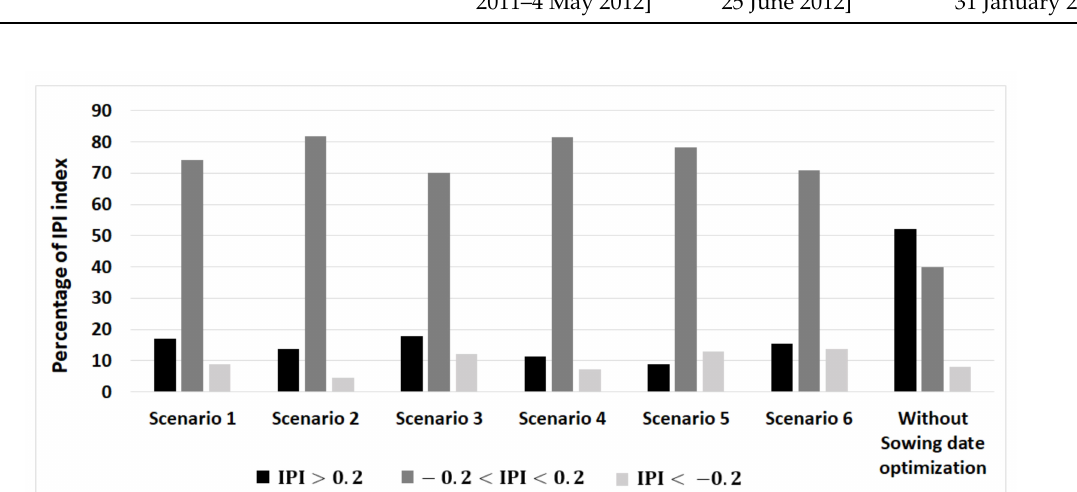
Figure 11. IPI index distribution with sowing date optimization (for each sowing date) and without sowing date optimization (from previous study) at the third irrigation round of the 2011–2012 agricultural